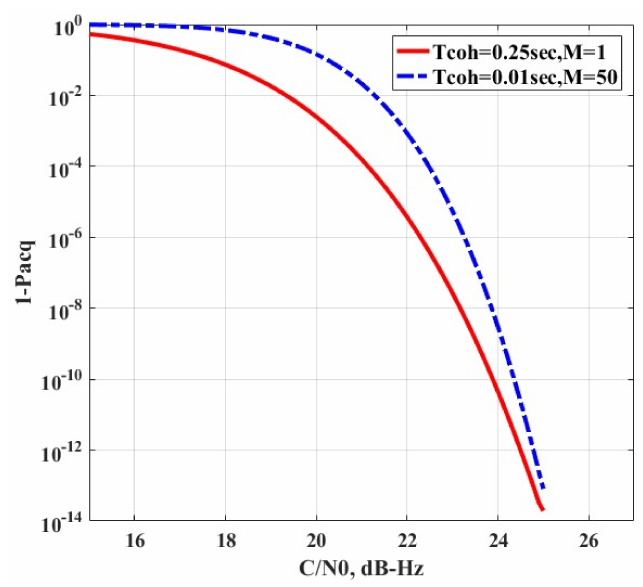
Figure 9. Comparisons of carrier acquisition probability for different integration approaches.